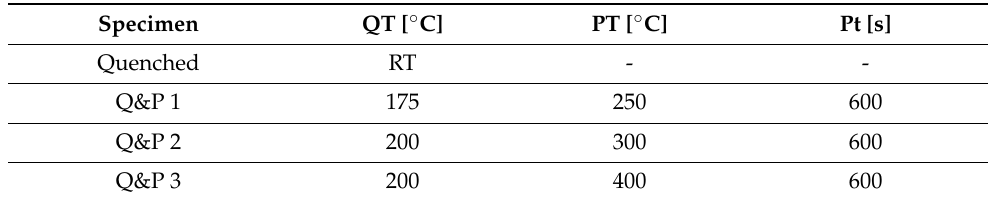
Table 2. Overview of processing parameters (quenching temperature QT, partitioning temperature PT and partitioning time Pt) for Q&P